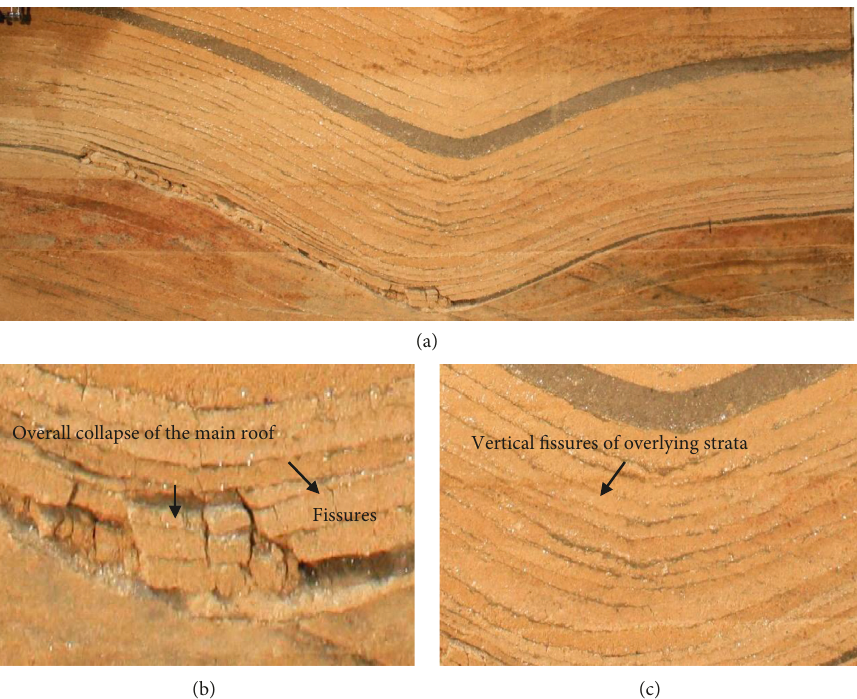
Figure 8: The main roof collapses in the synclinal axis and fissure development of the overlying strata. (a) The whole picture of the model after the breakage caving of the main roof. (b) Overall collapse of the main roof. (c) Vertical fissures of the overlying strata.